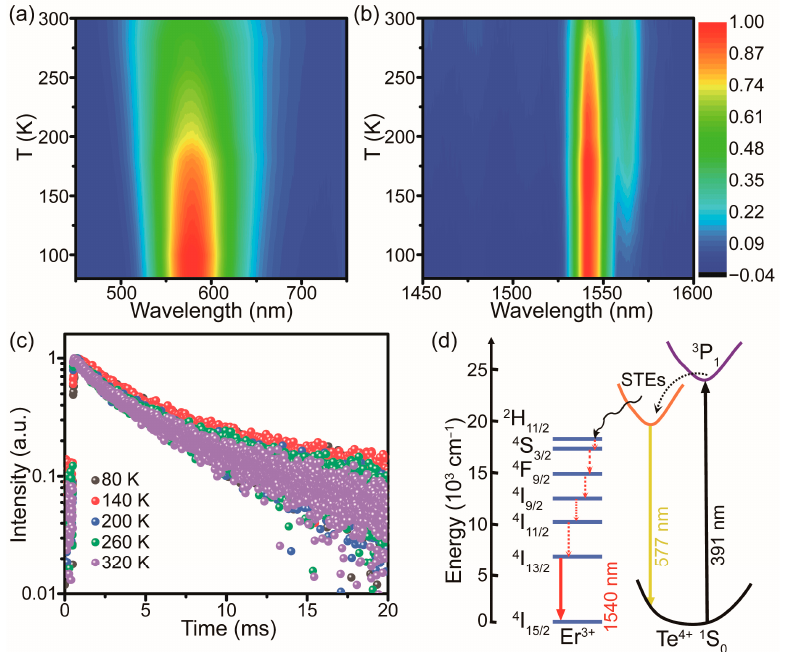
Figure 4. Contour plots of the normalized temperature-dependent PL emission spectra of Te 4+ /Er 3+ - co-doped Cs 2 SnCl 6 microcrystals under excitation at 391 nm ( a ) in the visible region and ( b ) in the NIR region. ( c ) PL decay curves of 1540 nm emission measured at different temperatures in Te 4+ /Er 3+ -co-doped Cs 2 SnCl 6 microcrystals ( λ ex = 391 nm). ( d ) Schematic illustration of luminescence mechanisms in Te 4+ /Er 3+ -co-doped Cs 2 SnCl 6 microcrystals. The full, dashed, and curve arrows represent the radiative transition, non-radiative transition, and energy transfer process, respectively.